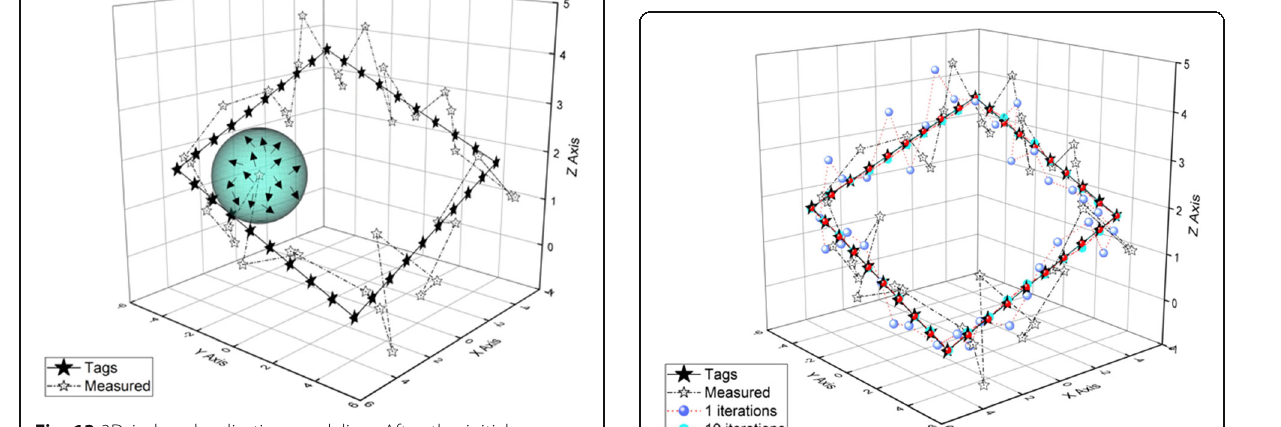
Fig. 13 3D indoor localization modeling. After the initial 2D configuration. The only difference is that we model the